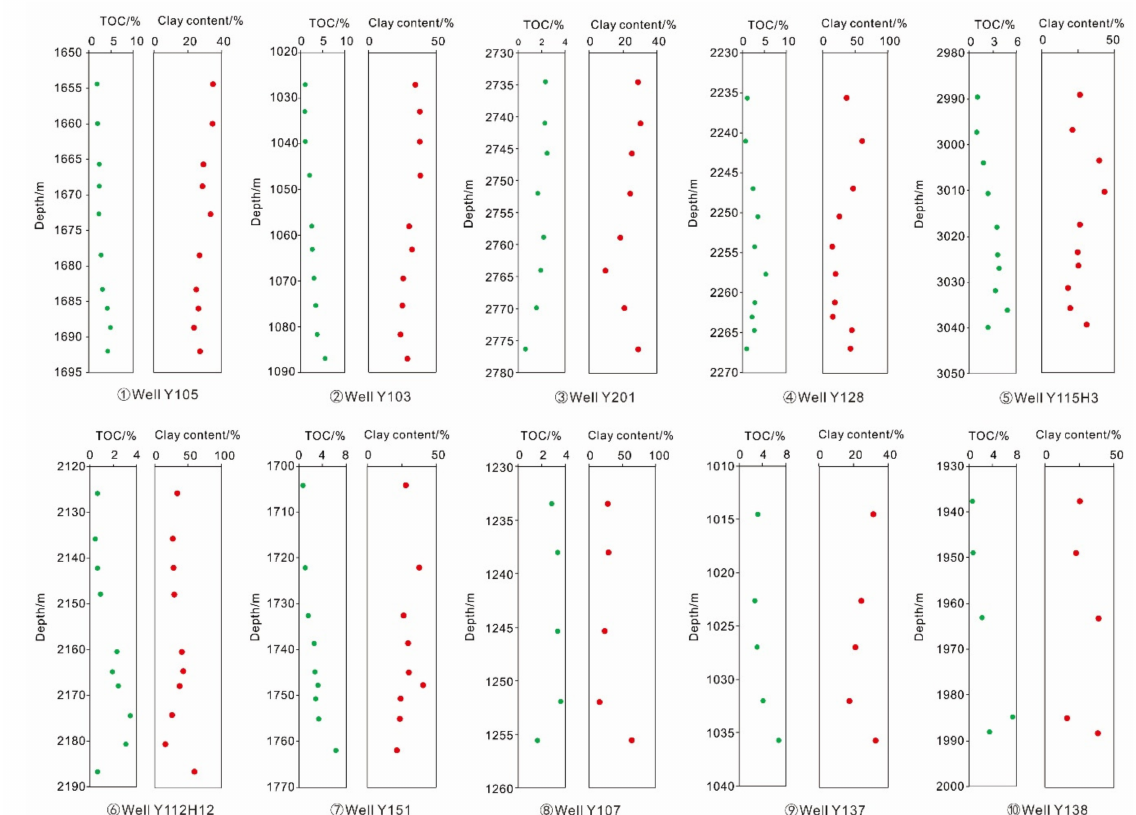
Figure 3. Variation of the TOC and clay content with the depth of the 10 wells. A total of 82 data points is shown in this